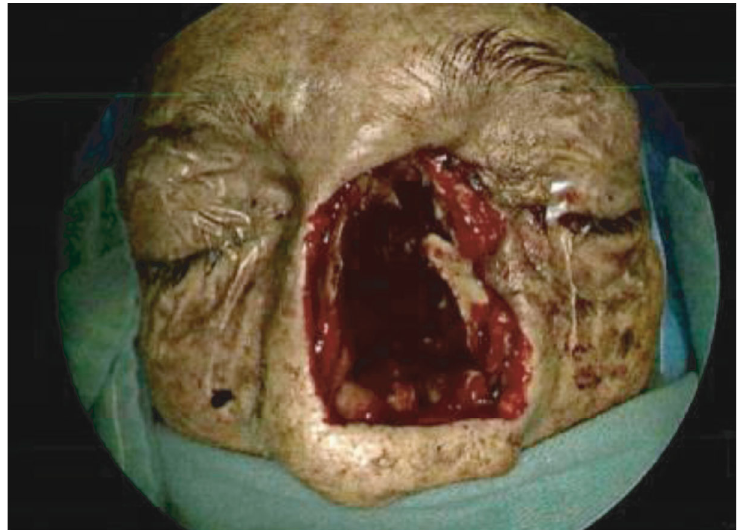
Figure 4: Patient 3 postsurgical intervention.